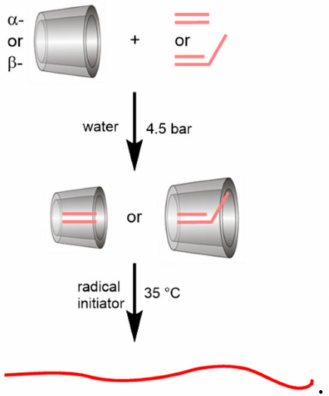
Figure 1. General scheme of the cyclodextrin-assisted aqueous radical polymerization of ethylene and